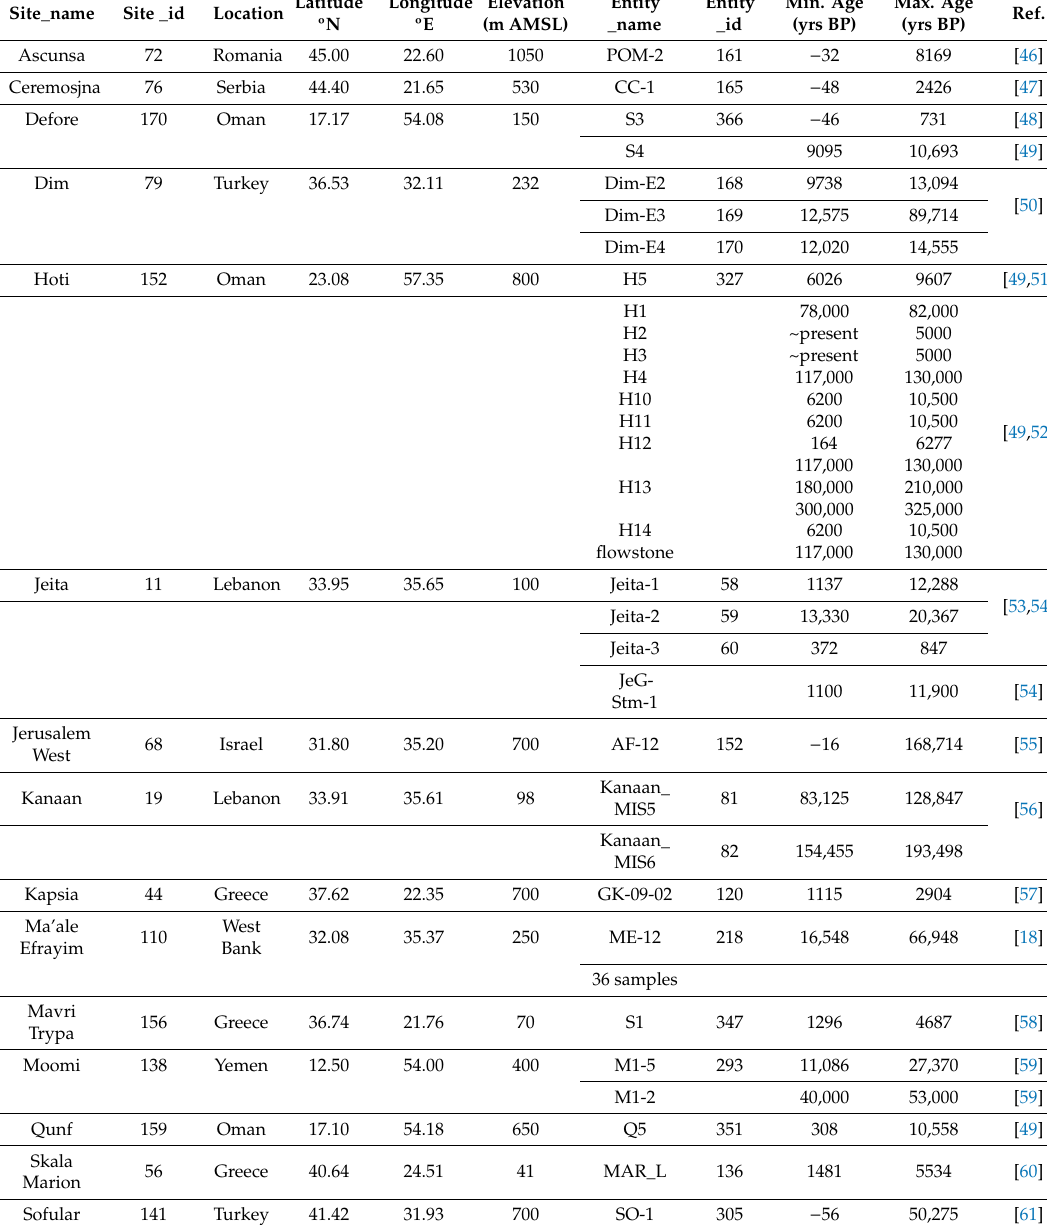
Table 1. List of all speleothem records which include SISAL metadata: site (or cave) name and id number, latitude, longitude, entity (or speleothem) name and id number. Additional information includes; location of site (country or region), site height Above Mean Sea Level (AMSL) in meters, minimum and maximum ages given in years BP (1950), and published references. The top table are records available in SISAL_v1 (with annotations of some entities in those sites as yet to be added to SISAL_v1). The bottom table lists additional sites and speleothems not included in in SISAL_v1. A minimum age of “~present” is designated where a younger than 1950 CE sample is presented without an exact minimum age for the age model or a removal date. When ages beyond U / Th dating method are reported, the table notes these as > U /